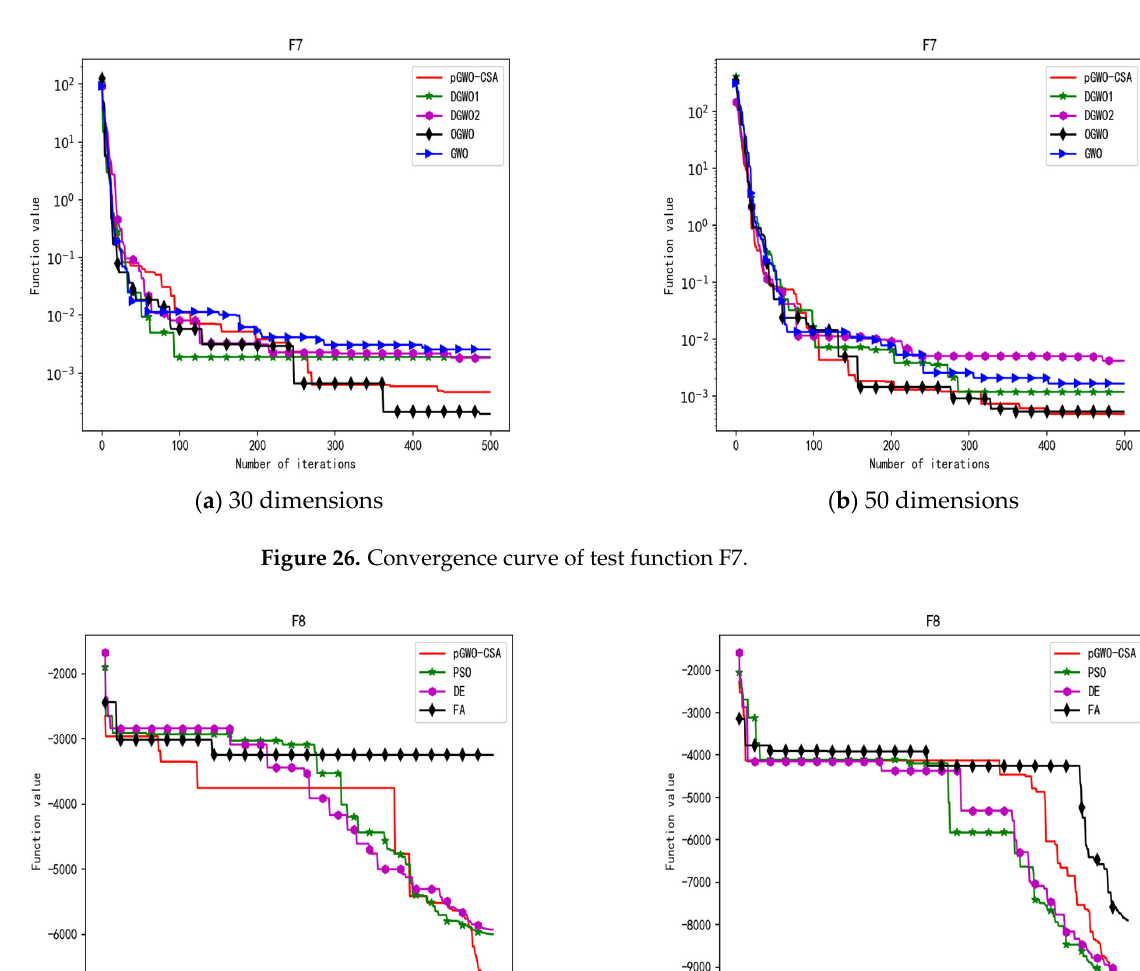
Figure 25. Convergence curve of test function F6.